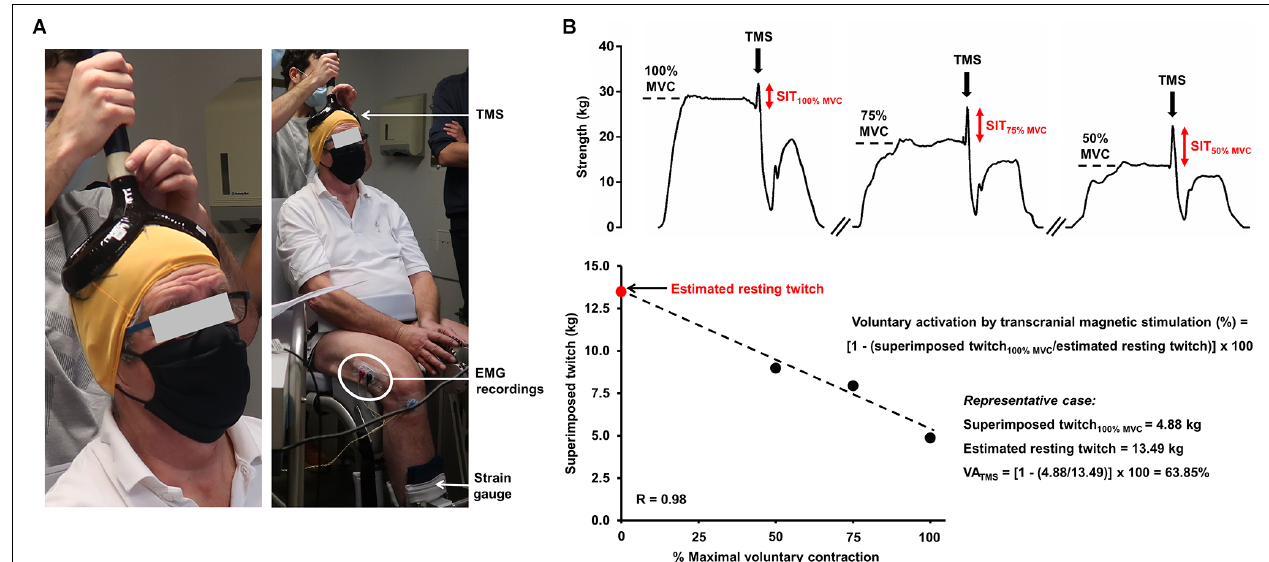
FIGURE 1 | Experimental setting required for the assessment of neuromuscular fatigue using transcranial magnetic stimulation (panel A ) and determination of voluntary activation by transcranial magnetic stimulation (panel B ). (A) A pulse is delivered to the brain area corresonding to the motor cortex (preliminarily determined) during a voluntary contraction and the evoked muscle strength is recorded with an appropriate ergometer (strain gauge). Strength measures may also be couple with EMG recordings. (B) The exposed case depicts the determination of voluntary activation of the (unfatigued) knee extensors by transcranial magnetic stimulation in a 67-year old man with obstructive sleep apnea (apnea-hypopnea index = 35 events/hour). Specifically, the participant are asked to perform a brief maximal voluntary contraction followed by two submaximal contractions at 75% and 50% of maximal voluntary contraction. A pulse is applied to the skull, corresponding to the motor cortex, at these different strength levels after obtaining a plateau. The linear relationship between the voluntary strength and the evoked muscle strength by the pulse (superimposed twitch) allows the estimated resting twitch to be determined. The superimposed twitch obtained at 100% of maximal voluntary contraction and the estimated resting twitch (theoretically obtained on the relaxed muscles) are then used for determining voluntary activation. The representative case shows a clear deficit in cortical voluntary activation in a fresh state since a submaximal value is obtained. Abbreviations. EMG, electromyography; MVC, maximal voluntary contraction; SIT, superimposed twitch; TMS, transcranial magnetic stimulation; VA, voluntary